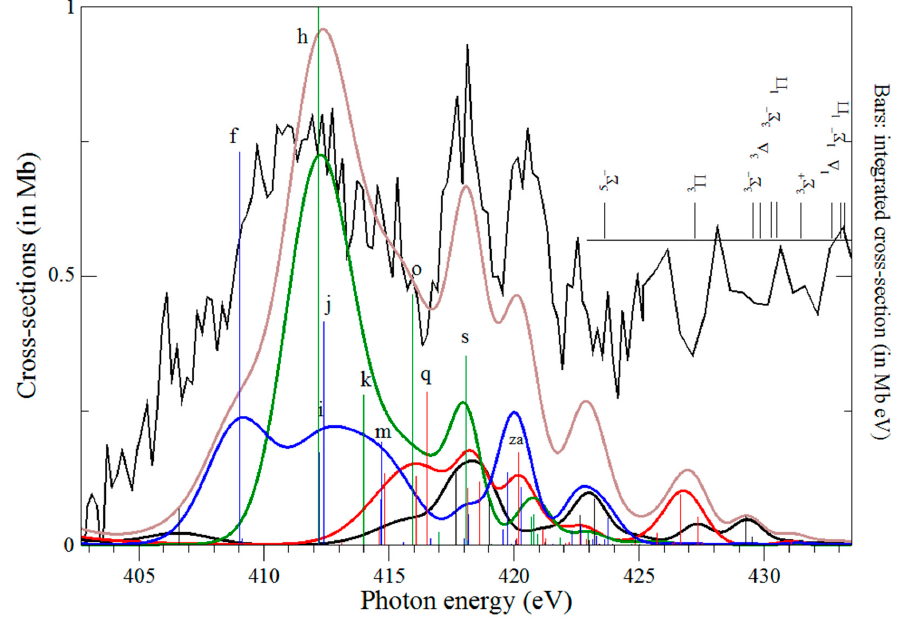
Figure 4. Experimental and simulated spectra in the energy region between 407 and 430 eV. Blue lines / bars: Quartet 4 Σ − and 4 Π states (quartet cross-sections were scaled by a factor of 0.5 to take into account source population e ff ects (see discussion in text)). Green lines: 2 Π states. Red lines / bars: 2 Σ − and 2 ∆ states. Black lines / bars: 2 Σ + and 2 ∆ states. Cross-sections are given in Mb. Bars: Integrated cross-section under the peaks (in Mb eV). Experimental intensities were divided by a factor of eight (see text). The calculated energy positions of the ten lowest lying ionization thresholds are shown in the top right corner. Table 5. First ten low-lying N1s − 1 vertical ionization energies calculated at the configuration interaction single and double substitutions (CI-SD) level of theory. *Absolute density functional theory (DFT) triplet ( 2 Π → 3 Π ) and quintet ( 4 Σ − → 5 Σ − ) N1s − 1 vertical ionization energies at R D = 1.077 Å and R Q = 1.113 Å respectively, taking into account relativistic corrections (0.2 eV), were used as references. For each final state, the contributions of the main configurations are given in parentheses (%). Threshold